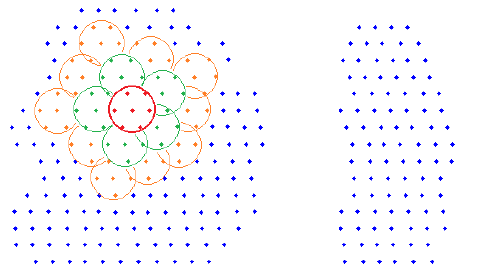
Figure 3: Determination of connected components. An arbitrary ball (red) is chosen and it is expanded by an iterative process where overlapping balls are added to the existing